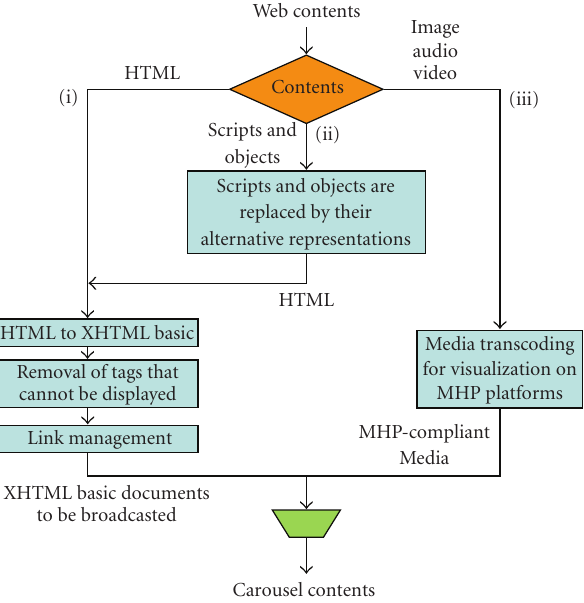
Figure 8: Transcoding Web contents for